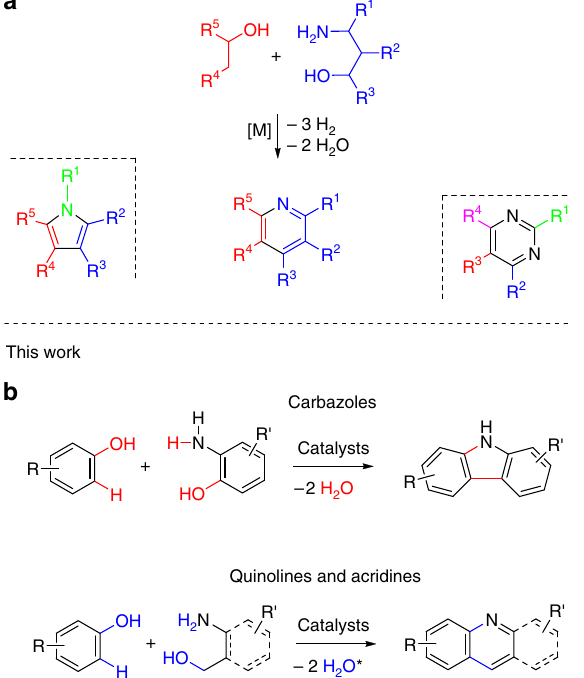
Fig. 2 Reaction sequence and catalyst screening. a The condensation of phenols and aminophenols via hydrogenation and multiple dehydrogenation/condensation steps. b Identi fi cation of an ef fi cient hydrogenation and dehydrogenation catalyst. Reaction